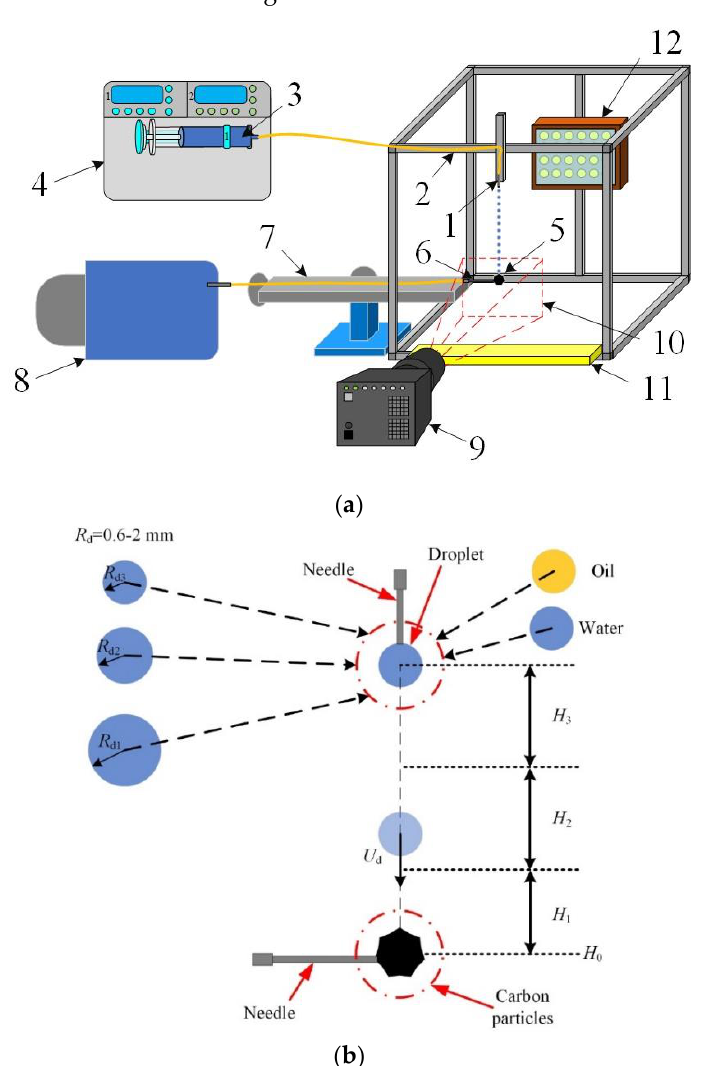
Figure 1. Schemes of the setup ( a ) and experiment ( b ): 1 — detachable nozzles of different diame-